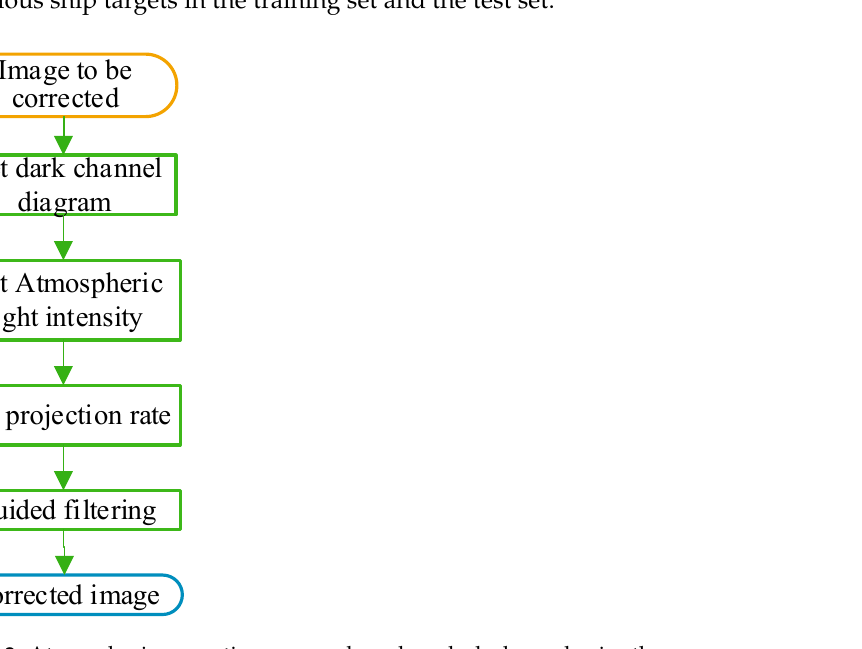
Figure 2. Atmospheric correction process based on dark channel prior theory.